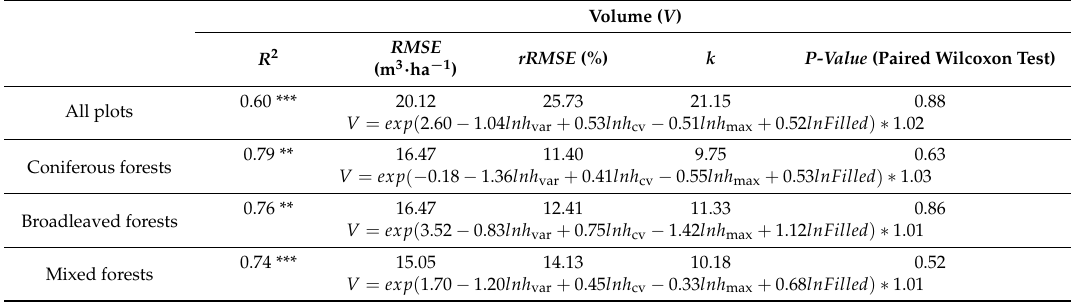
Table 2. A summary of fitting statistics for predicted plot total volume ( V ) models.